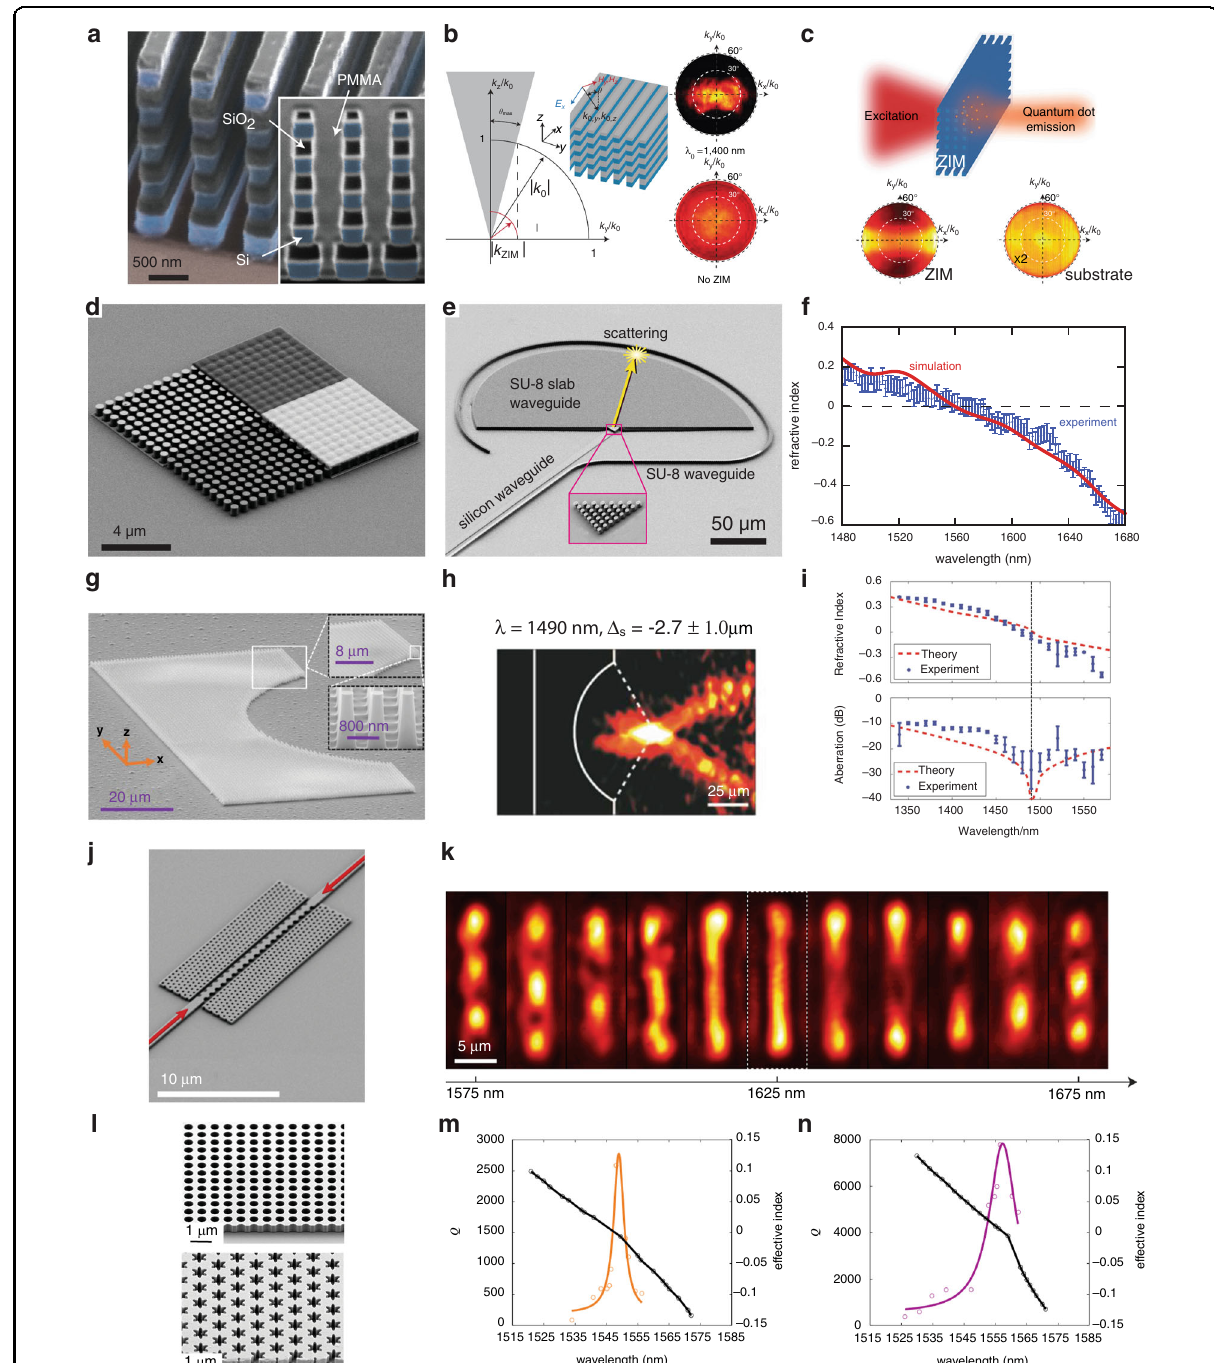
Fig. 5 Optical DCZIMs ’ structures, theoretical and experimental results. a Scanning electron microscopy (SEM) image of an out-of-plane zero- index metamaterial with the experimental demonstration of this metamaterial ’ s small angular selectivity b and directional emission from quantum dots within this metamaterial ( c ). d SEM images of an in-plane zero-index metamaterial and e the waveguides and metamaterial for measuring the zero index with f the simulated and measured effective indices. g In-plane zero-index lens with its optical microscope image ( h ), effective refractive index (top), and longitudinal spherical aberration (bottom) i . j SEM image of an in-plane zero-index waveguide with its measured interference patterns at different wavelengths ( k ). l SEM images of in-plane resonance-trapped (top) and symmetry-protected (bottom) BIC zero-index metamaterials with their measured quality factors and effective refractive indices, respectively ( m , n ). Figure adapted with permission from a – c ref. 56 , Springer Nature Limited; d – f ref. 57 , Springer Nature Limited; g – i ref. 78 , American Chemical Society; j – k ref. 31 , American Chemical Society; l – n ref. 55